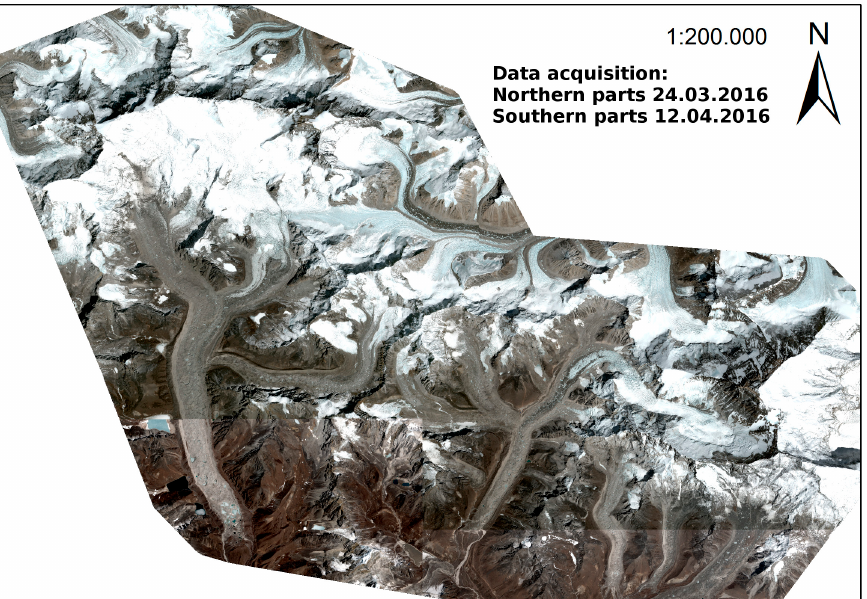
Figure 4. Overview of the spring 2016 Pléaides images of the Khumbu Himal study area. UTM 45 N.